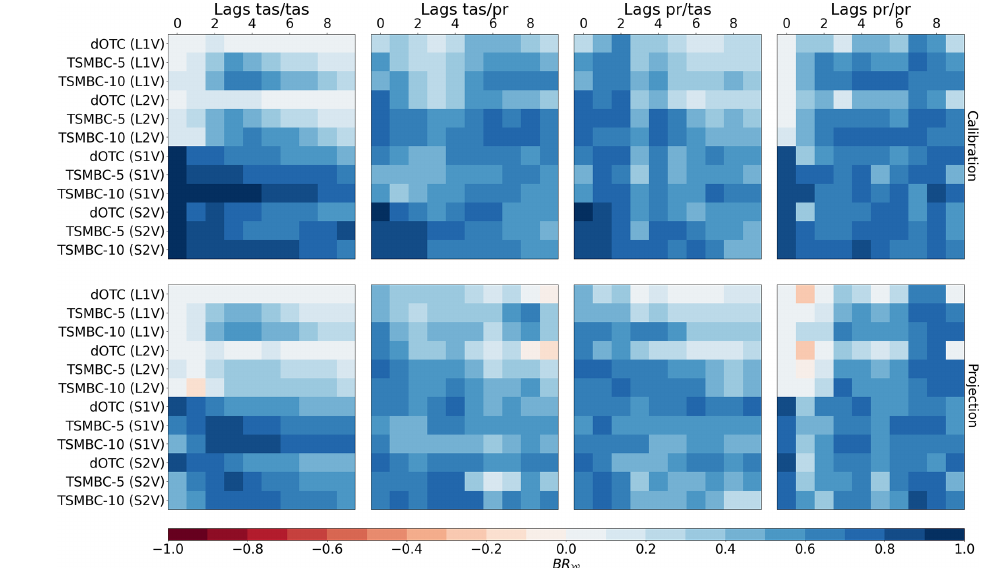
Figure 8. Bias reduction of dependence (BR W ) values, based on the Wasserstein distances computed on bivariate (correlation, distance) distributions between reference and the different BC datasets or model simulations in summer. The (correlation, distance) 2-D distributions come from the calculated correlograms (see Fig. 7 and text for details). The first line of matrices corresponds to the calibration period, and the second line to the projection period. The BC results and model simulations correspond to rows. The correlations are calculated between tas and tas (first matrix), tas and pr (second matrix), pr and tas (third matrix), and pr and pr (fourth matrix). For each matrix, the columns correspond to different lags and thus correlations indicate auto-correlations. Hence, the two central matrices (tas/pr and pr/tas) contain cross- correlations and cross-auto-correlations. In order to compare the shape of a (correlation, distance) set, a normalization is performed separately for each cell (i.e. each couple’s method lag) of each matrix. This normalization allows us to characterize the pattern of the distributions, and to get rid of the marginal properties. Hence, the comparison between different couples’ method lag is possible but only to characterize the shape of the (distance, correlation) distributions. The closer the BR W value is to 1, the closer the results are to the reference and therefore the better they are.